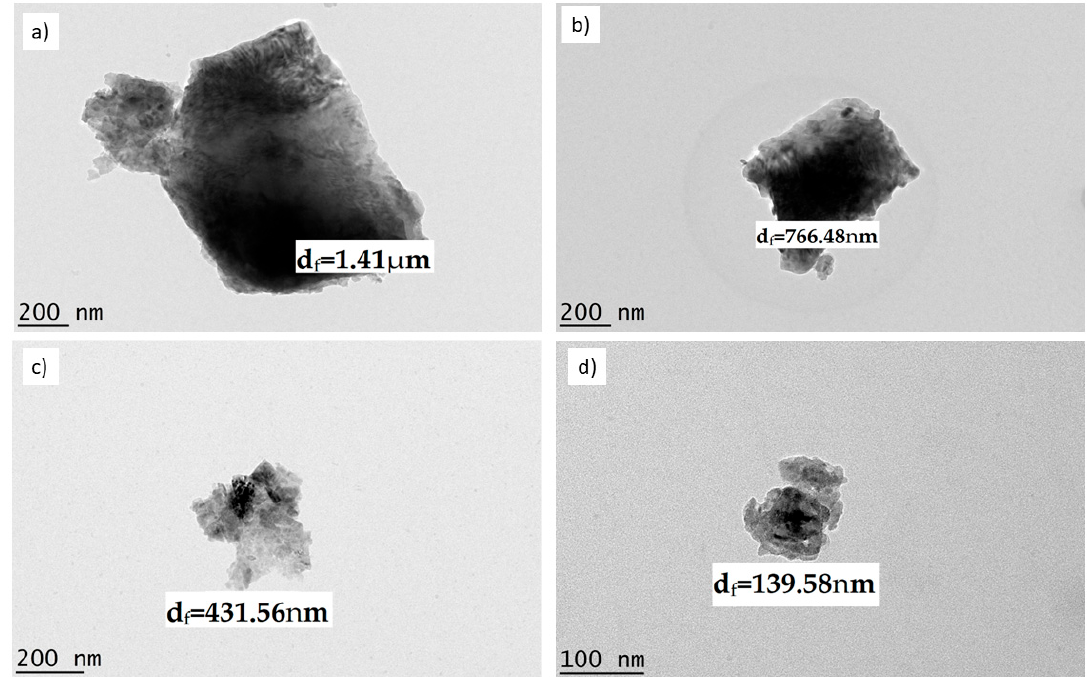
Figure 4. TEM images of dolomite that has been ball-milled at 500 rpm and ultrasonicated for 2 h with ( a ) 30% amplitude and 1 repetition (D 301X ), ( b ) 50% amplitude and 2 repetitions (D 502X ), ( c ) 50% amplitude and 3 repetitions (D 503X ), and ( d ) 50% amplitude and 10 repetitions (D 510X ).